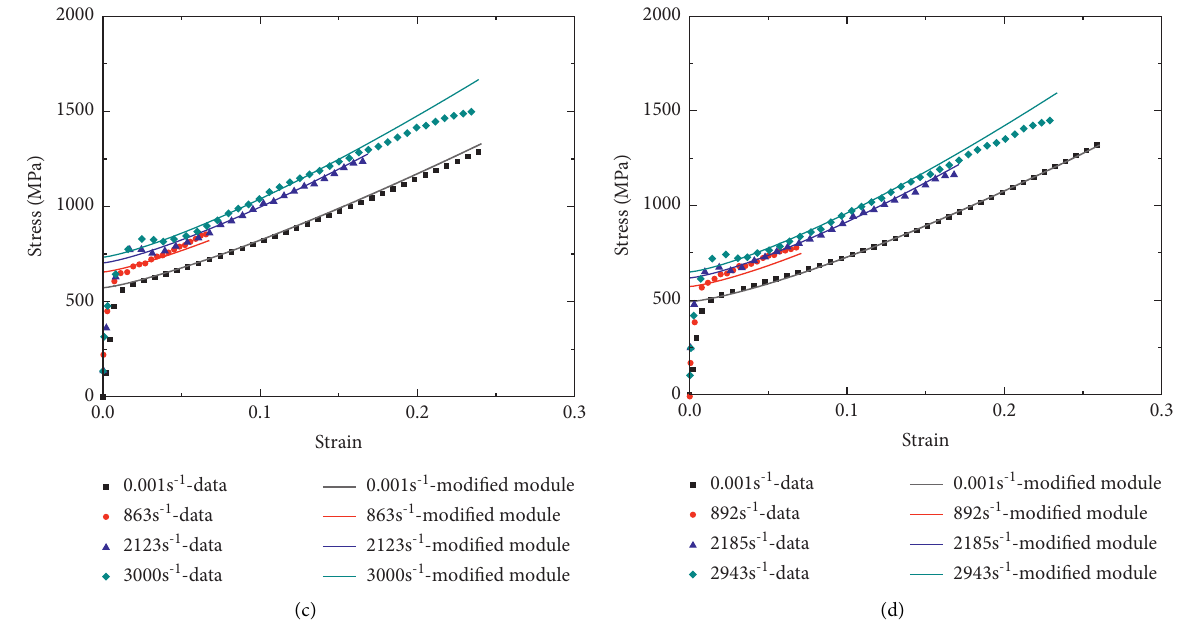
Figure 14: Stress-strain curve fitting after J-C constitutive modification. (a) 350mm/s, (b) 650mm/s, (c) 950mm/s, (d)